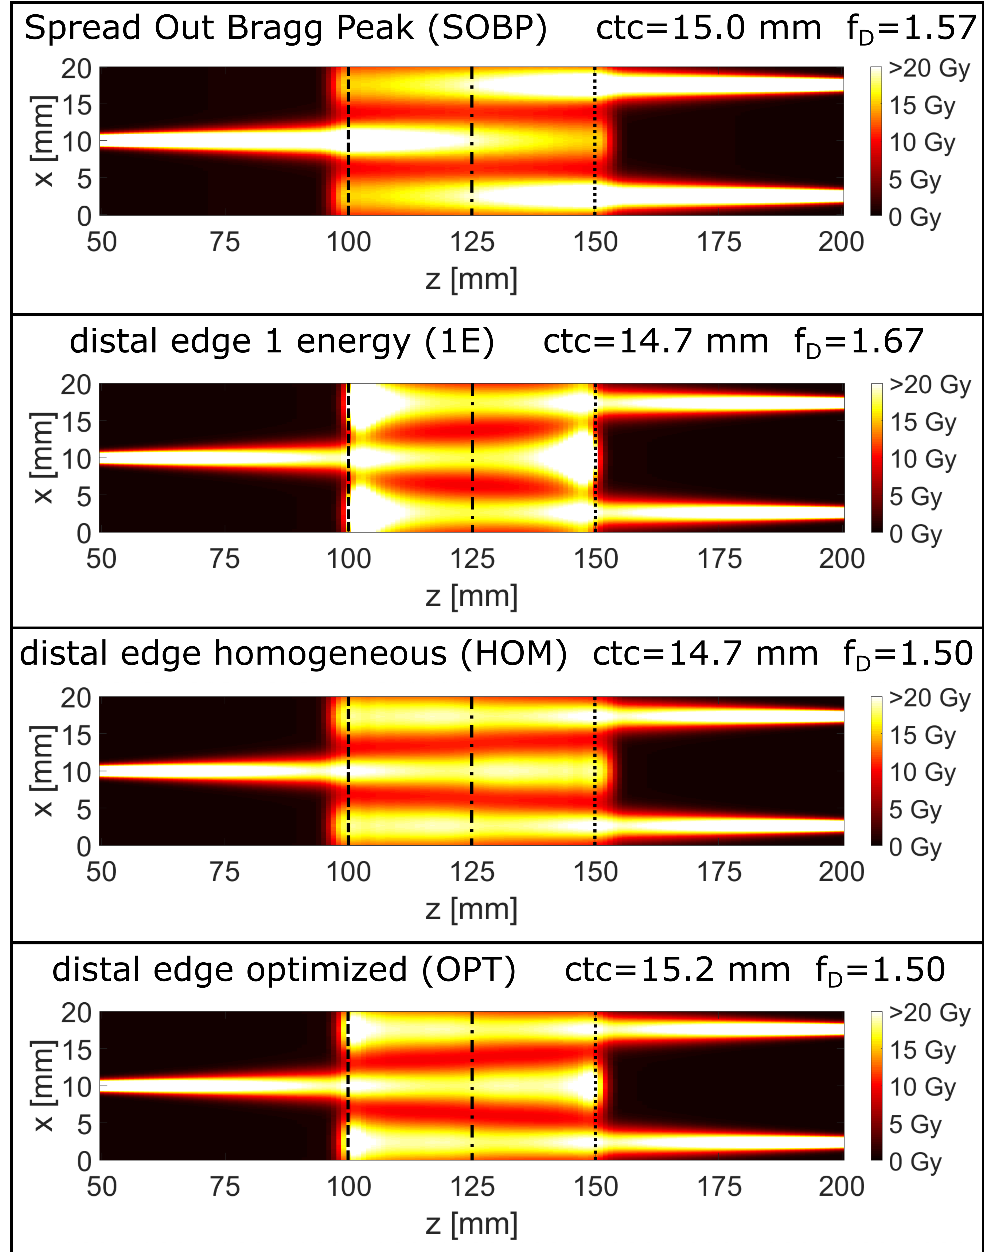
Figure 2. Dose maps for a longitudinal range of 50–200 mm and a lateral range of 20 mm of 2-directional, interlaced planar proton minibeams optimized for the different depth-dose distributions. The dose is color-coded with a saturation at 20 Gy. The dashed and the dotted lines mark the tumor edges at 100 mm (dashed) and 150 mm (dotted). The dashed–dotted lines mark the tumor center at 125 mm.